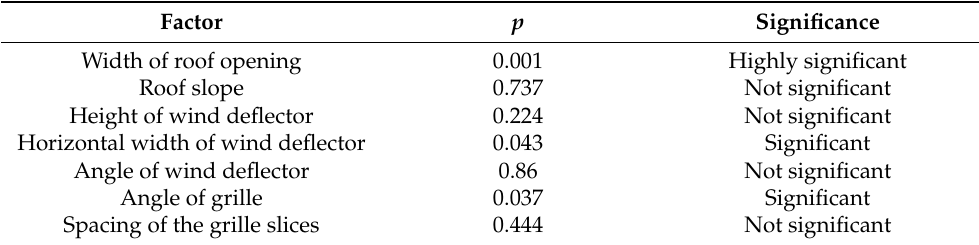
Table 3. Analysis of variance (ANOVA) table for volume flow